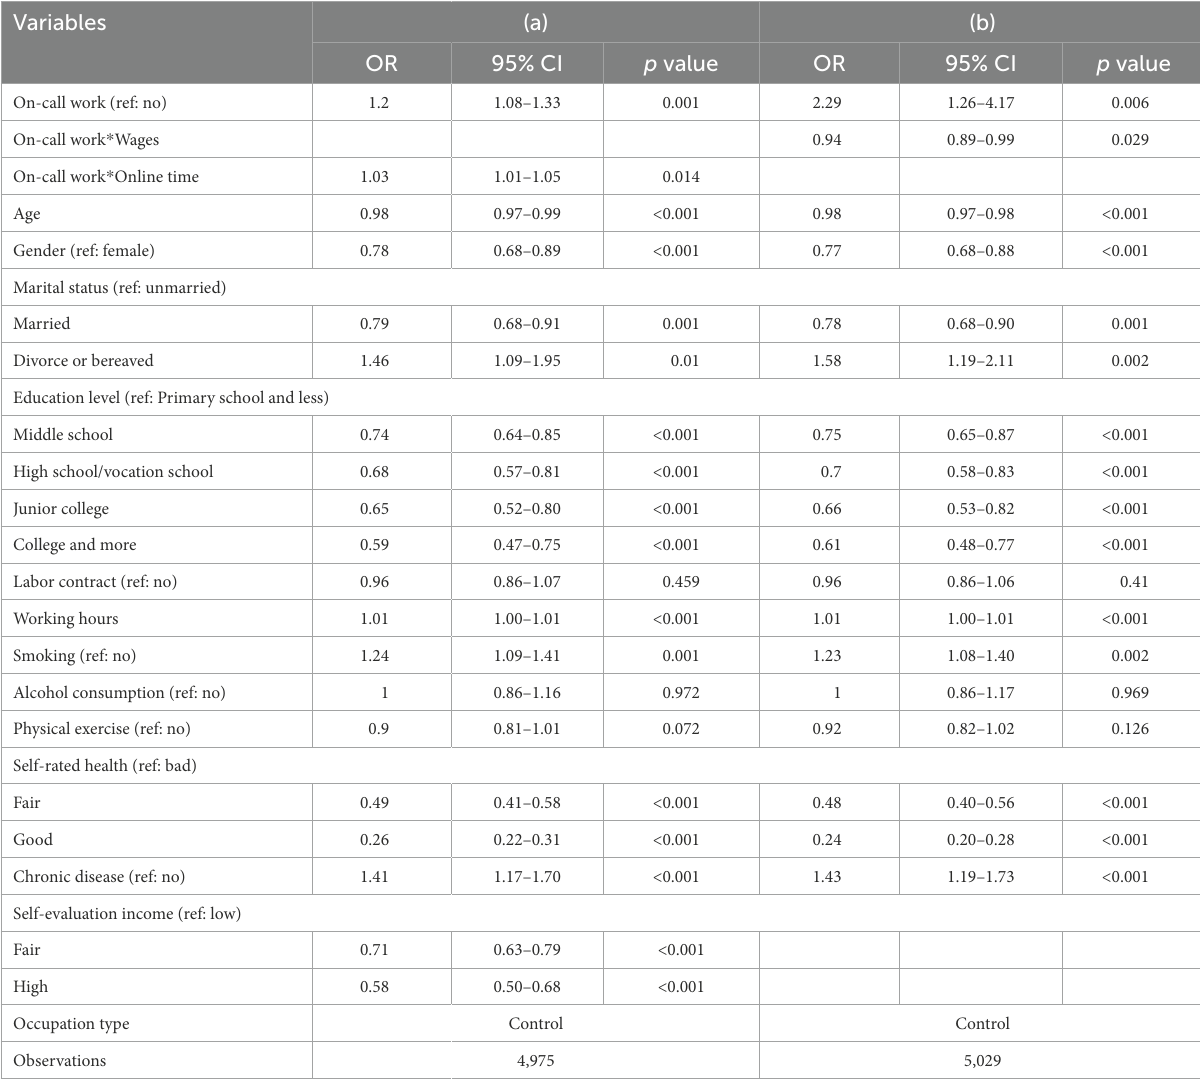
TABLE 5 Analysis of interaction